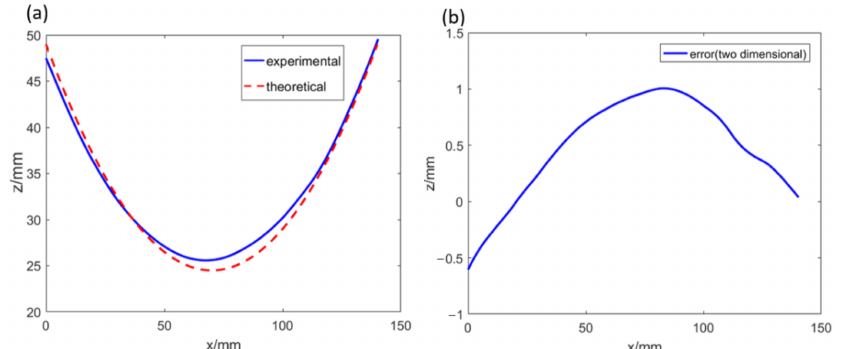
Figure 11. Comparison of outputs obtained by experiment and calculation: ( a ) height distributions of contour and ( b ) error